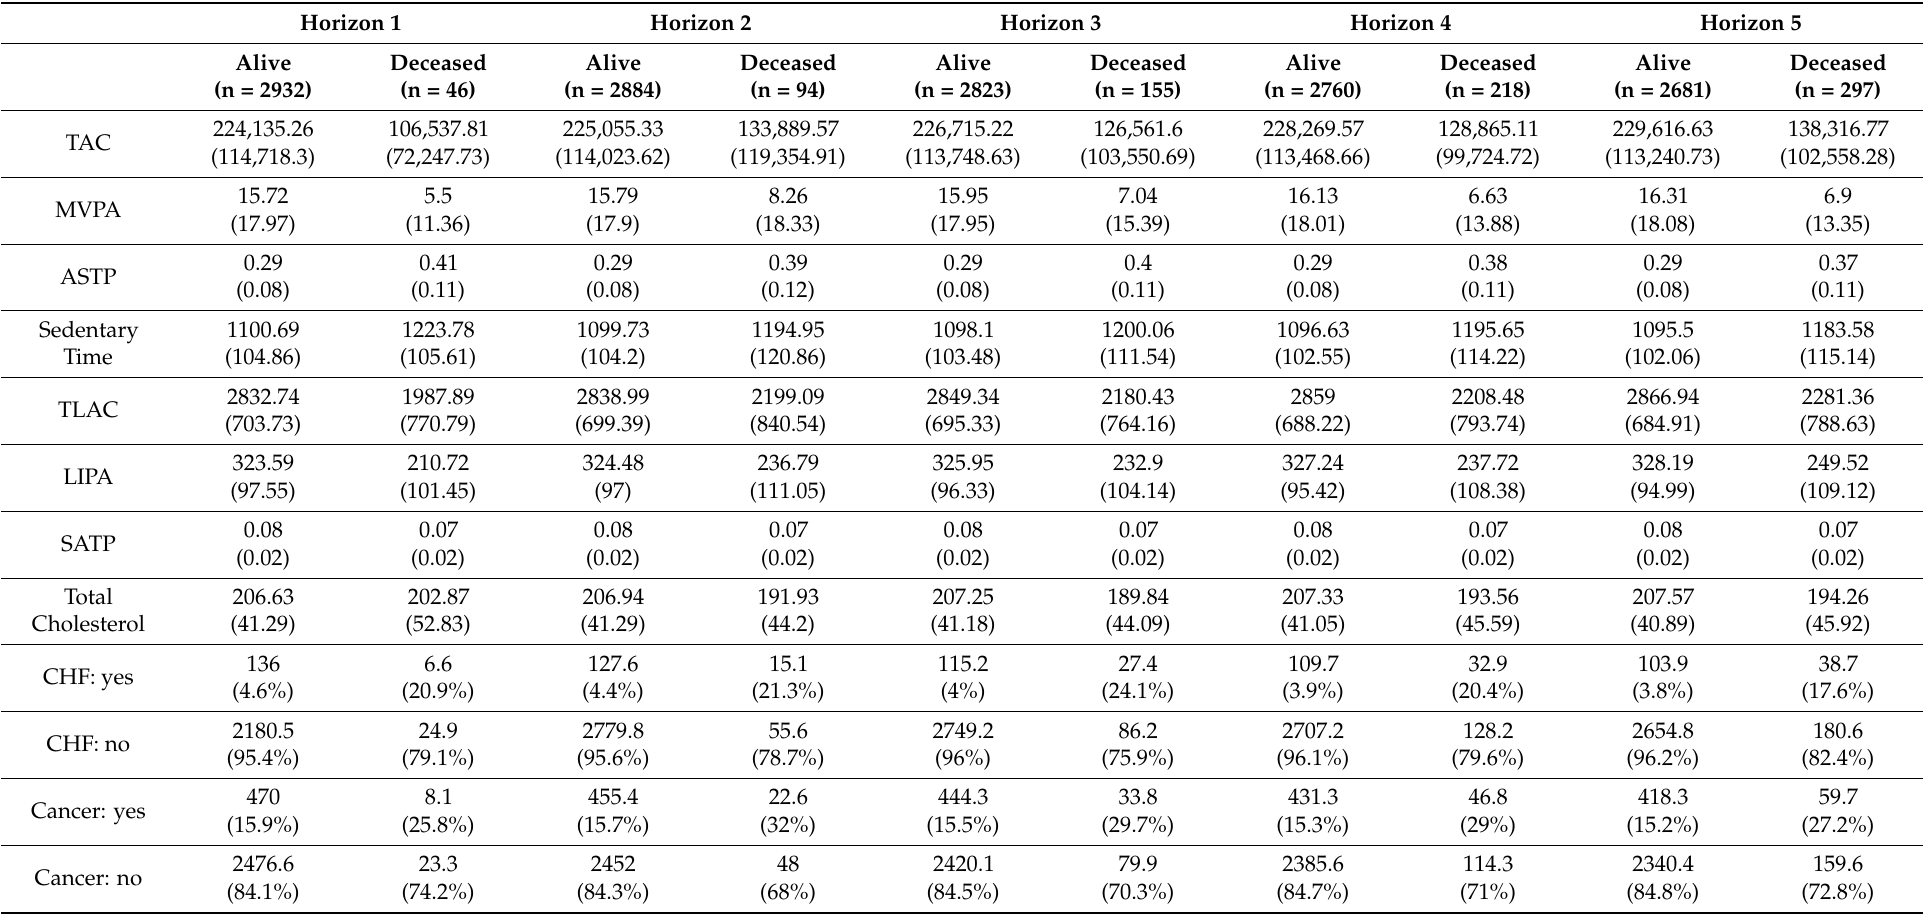
Table A1. Unadjusted number of alive and diseased participants and complex-survey adjusted comorbidities and physical activity characteristics separated by alive and deceased status for 1-, 2-, 3-, 4-, 5-years after the participation in the accelerometry study in NHANES 2003–2006